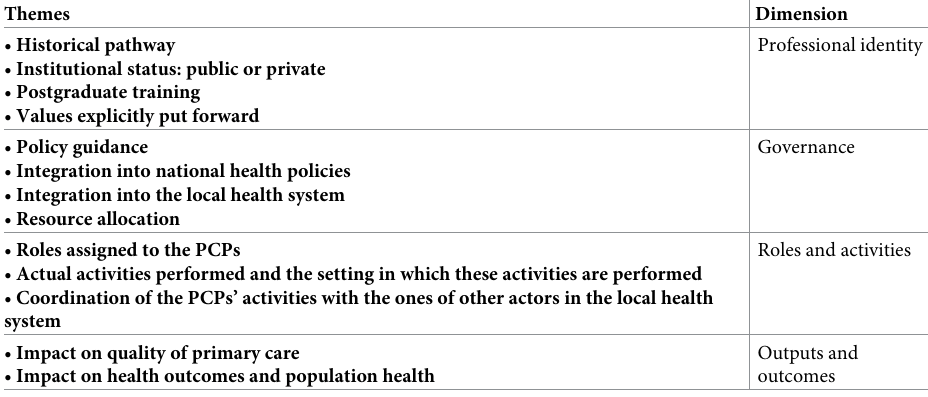
Table 4. Main dimensions for analysing FLMDs’ practices in